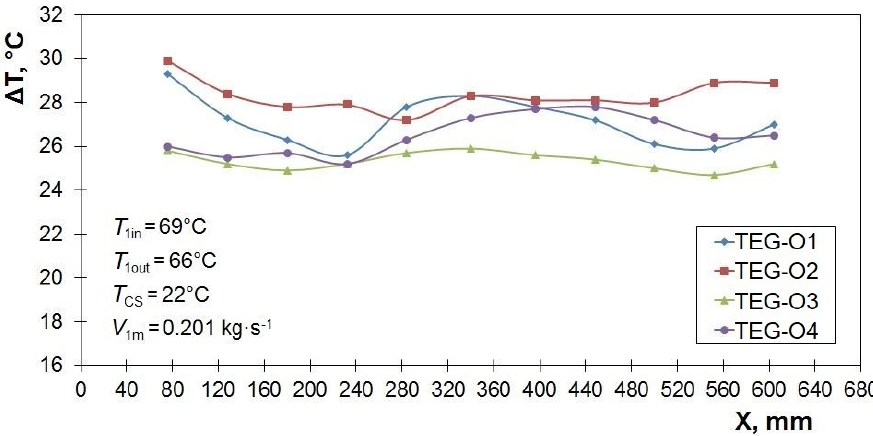
Figure 11. Distribution of the temperature difference along the surface of the HSHE in contact with the THM with different hot side fluid